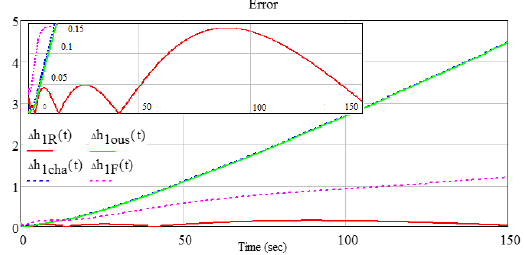
Fig. 8: Approximation error of time responses